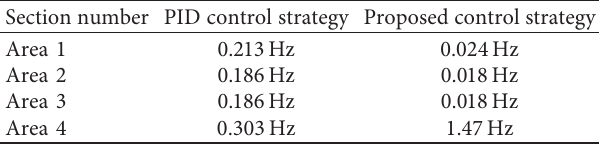
Table 5: The maximum frequency deviation of each region. Section number PID control strategy Proposed control strategy